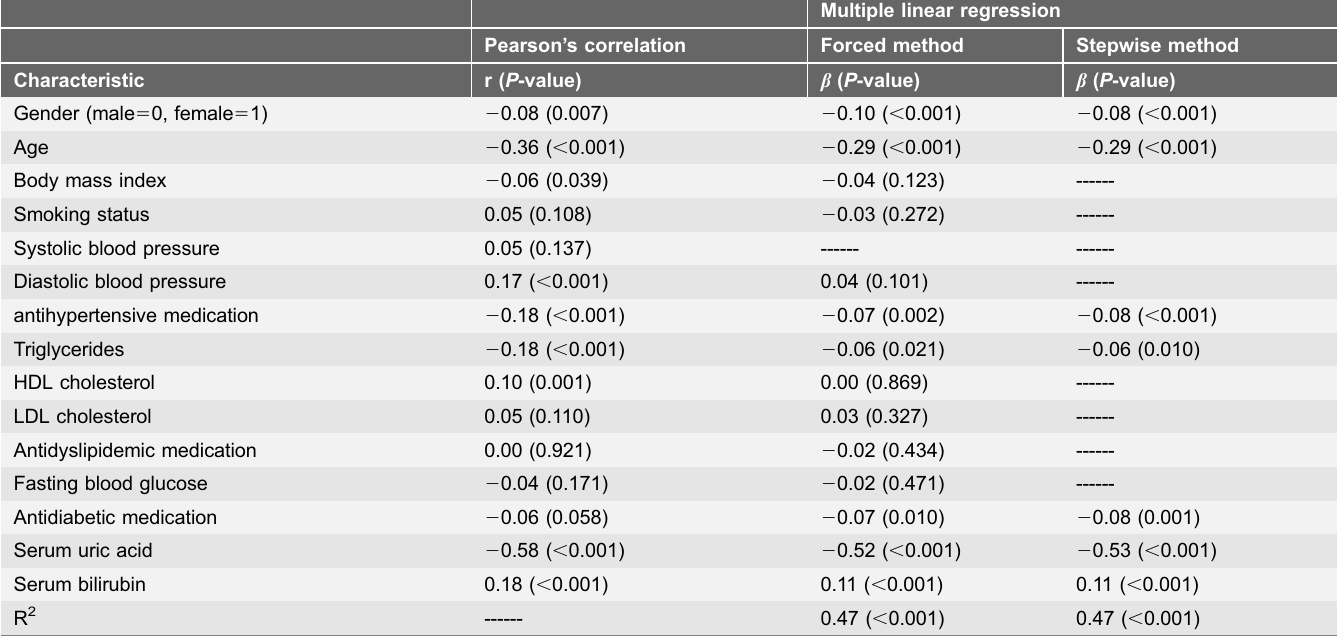
Table 3. Relationship between various risk factors including serum bilirubin and estimated glomerular filtration rate. Multiple linear regression Pearson’s correlation Forced method Stepwise